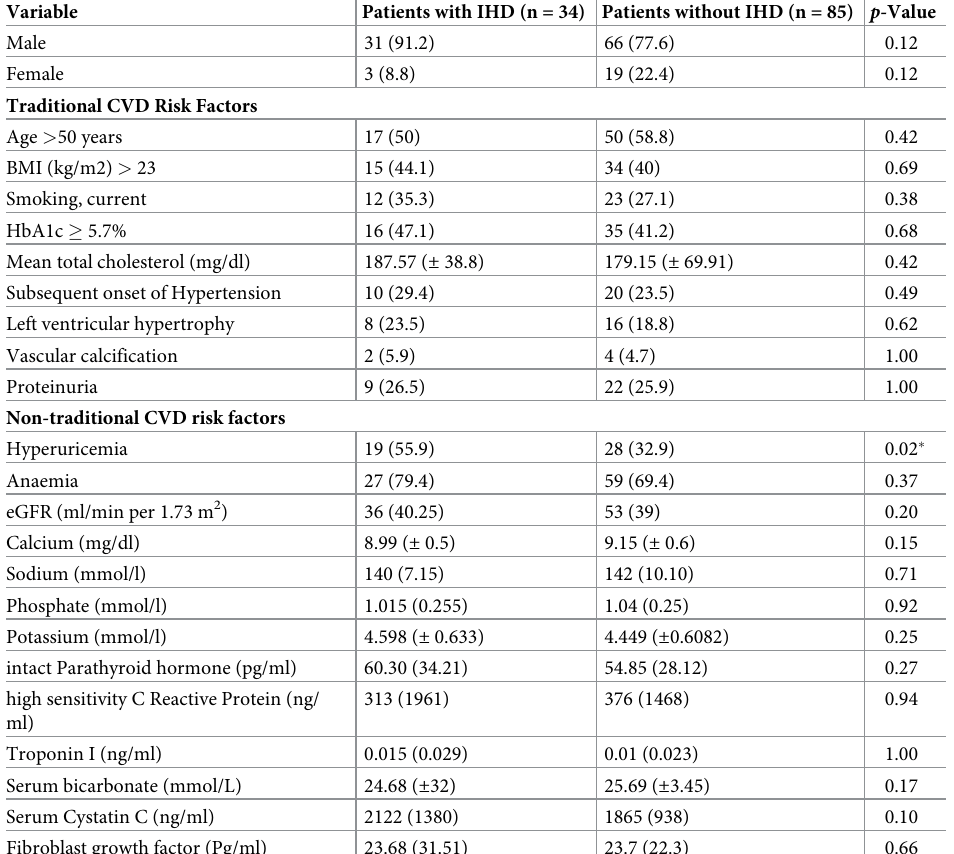
Table 4. Traditional and non-traditional cardiovascular risk factors in patients with and without IHD.